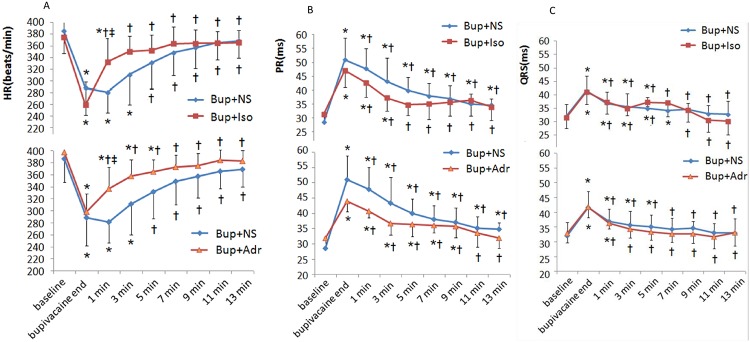
Chronotropic effect of β-adrenergic agonists in bupivacaine-intoxicated rats.(A) Bupivacaine significantly reduced HR, while adrenalin and isoprenalin restored HR. (B) Bupivacaine prolonged PR interval, while isoprenalin and adrenalin showed no effect on PR interval. (C) Bupivacaine widened QRS duration, while isoprenalin and adrenalin showed no improvement on QRS duration. *P < 0.05, vs. baseline; †P < 0.05, vs, bupivacaine end; ‡P < 0.05, vs. bupivacaine + NS group.